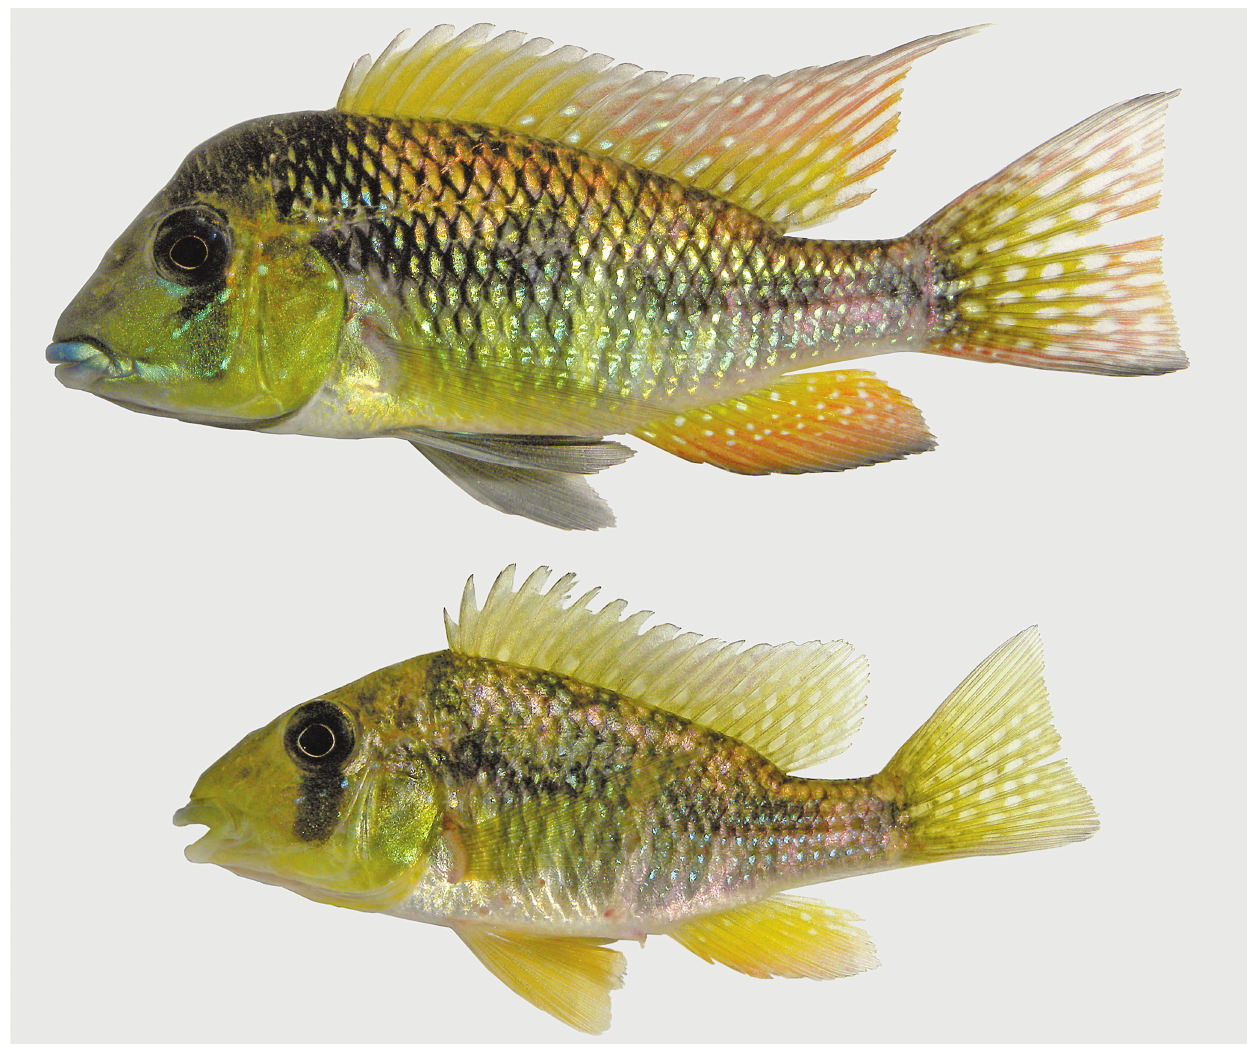
Fig. 5 . Gymnogeophagus peliochelynion : above, paratype, male, ZVC-P 13210, paratype, 76.3 mm SL, río Arapey, Colonia Lavalleja, Paso Elías, Salto, Uruguay; below, female, ZVC-P 13057, 65.3 mm SL, Arroyo Sopas, Paso del Cementerio, Salto, Uruguay. Photographs of live